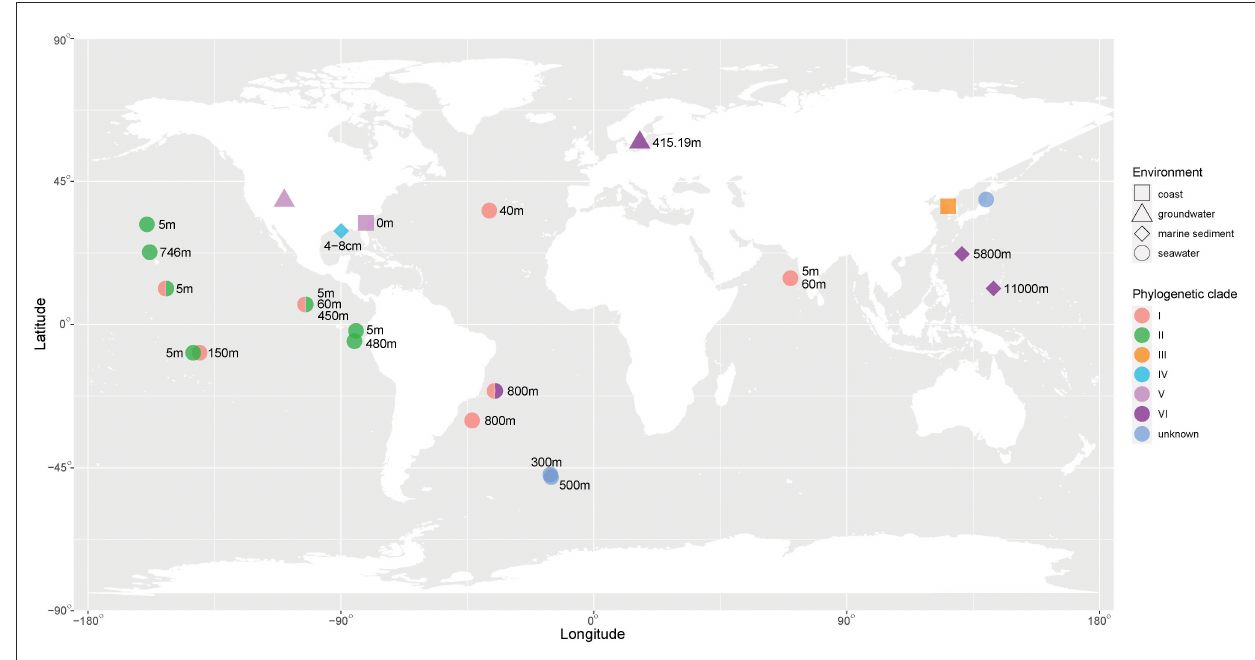
FIGURE2 Environmental distribution of Venatorbacter. The phylogenetic clades of Venatorbacter are in different colors. The environmental information is shown in various shapes. The available depth of the sampling sites is also